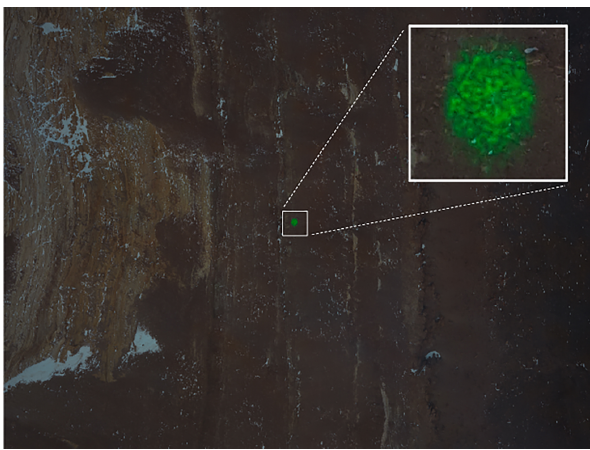
Figure 3. Image of the Titan channel 3 (532nm) laser footprint captured by the digital camera over the floor of Wright